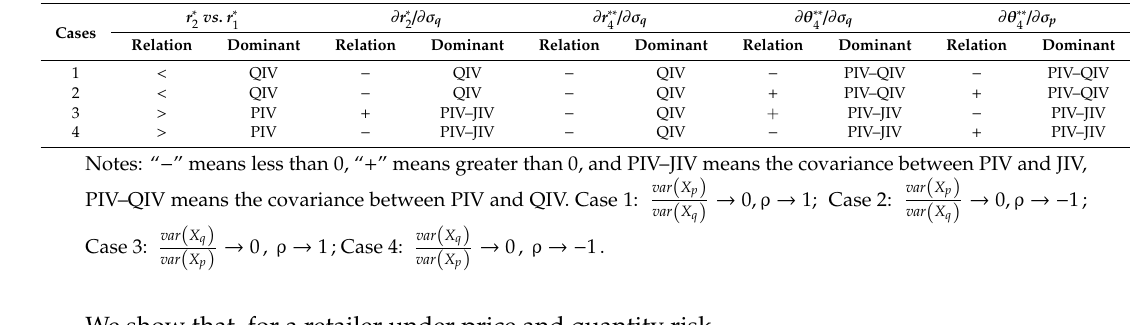
model 1. All other parameters were set according to the benchmark setup as in Table 1.